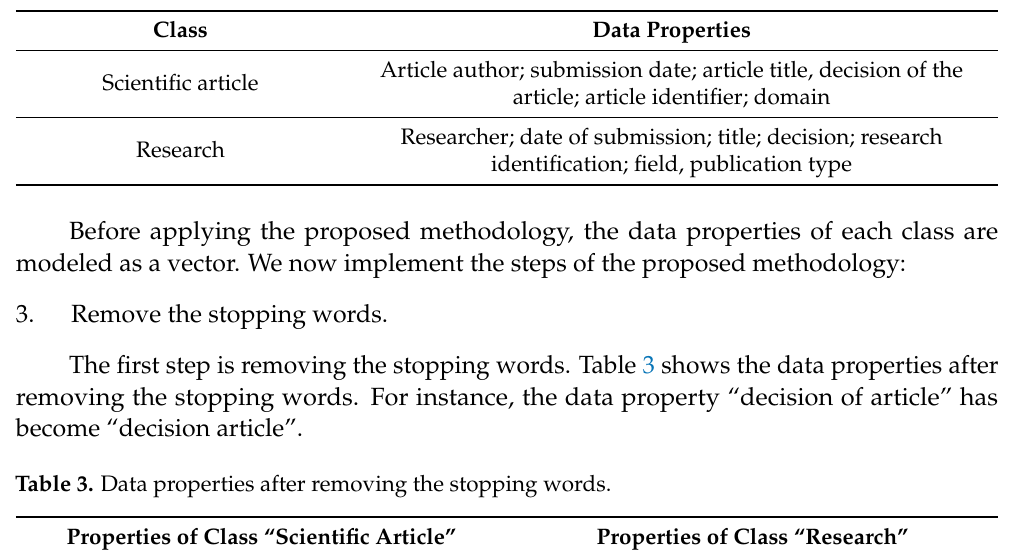
Table 2. Data properties of classes scientific article and research.